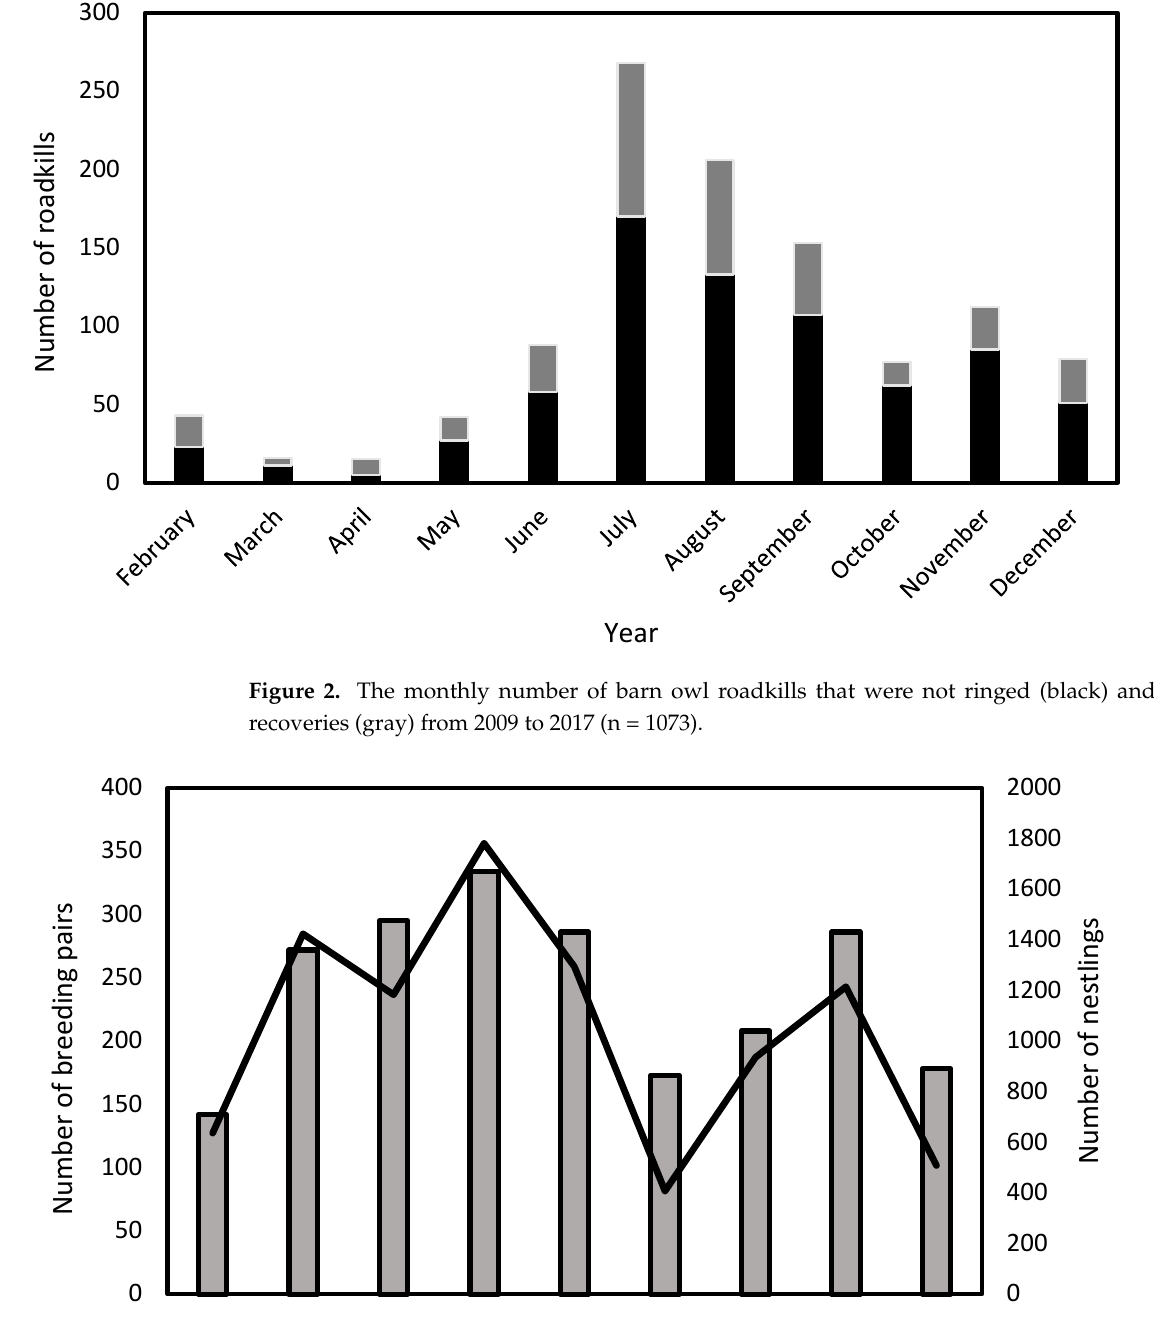
Figure 4. ( a , b ) The number of barn owl roadkills from 2009 to 2017 was positively related to the number of barn owl breeding pairs (a) and the number of nestlings ringed (b).